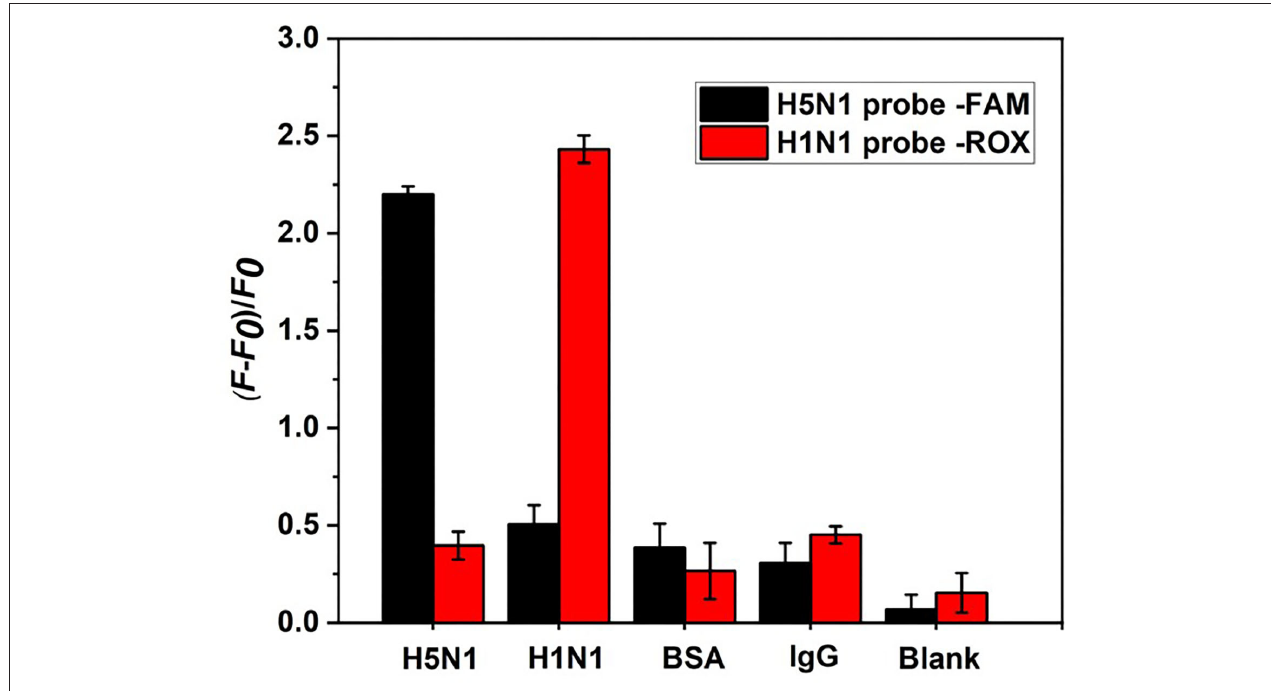
FIGURE 9 | Specificity analysis of the aptamer sensor. HA proteins from H1N1 and H5N1 act as counterpoint controls for each other. Background control protein BSA and human IgG are at a concentration of 20ng/ml.